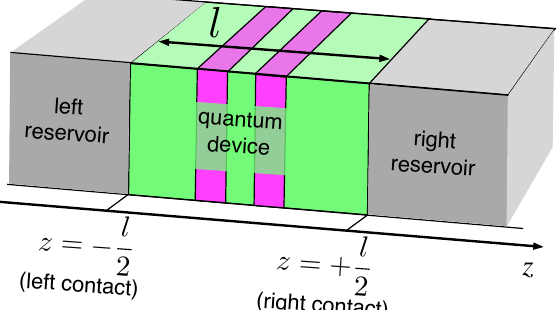
Figure 1. (Color online) Schematic representation of a typical semiconductor-based quantum device as an open system connected to two external charge reservoirs. Here, the distance between the interfaces is l and z is the longitudinal transport direction. Reprinted from